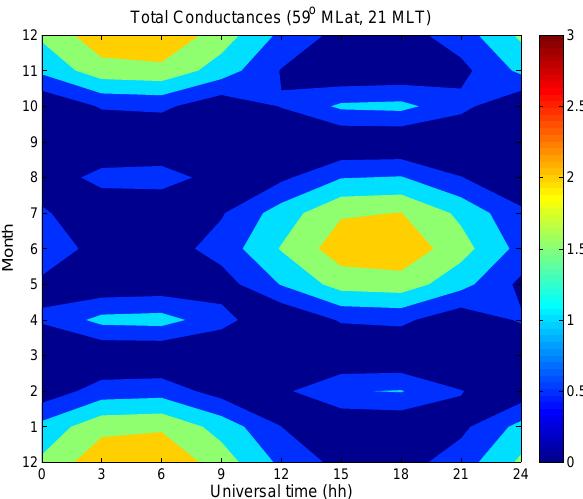
Fig. 6. Variation of fluxtube-integrated Pedersen conductivity, in S, caused by solar irradiation at conjugate footprints, ± 59 ◦ MLat, 21:00MLT.